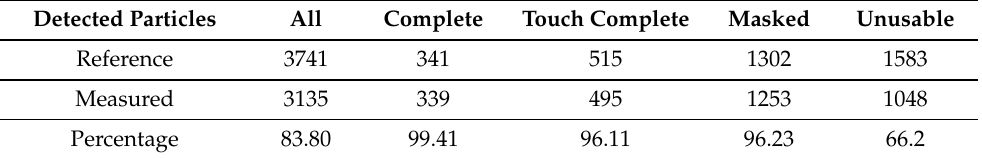
Table 2. Number of detected particles on the test set according to their type.